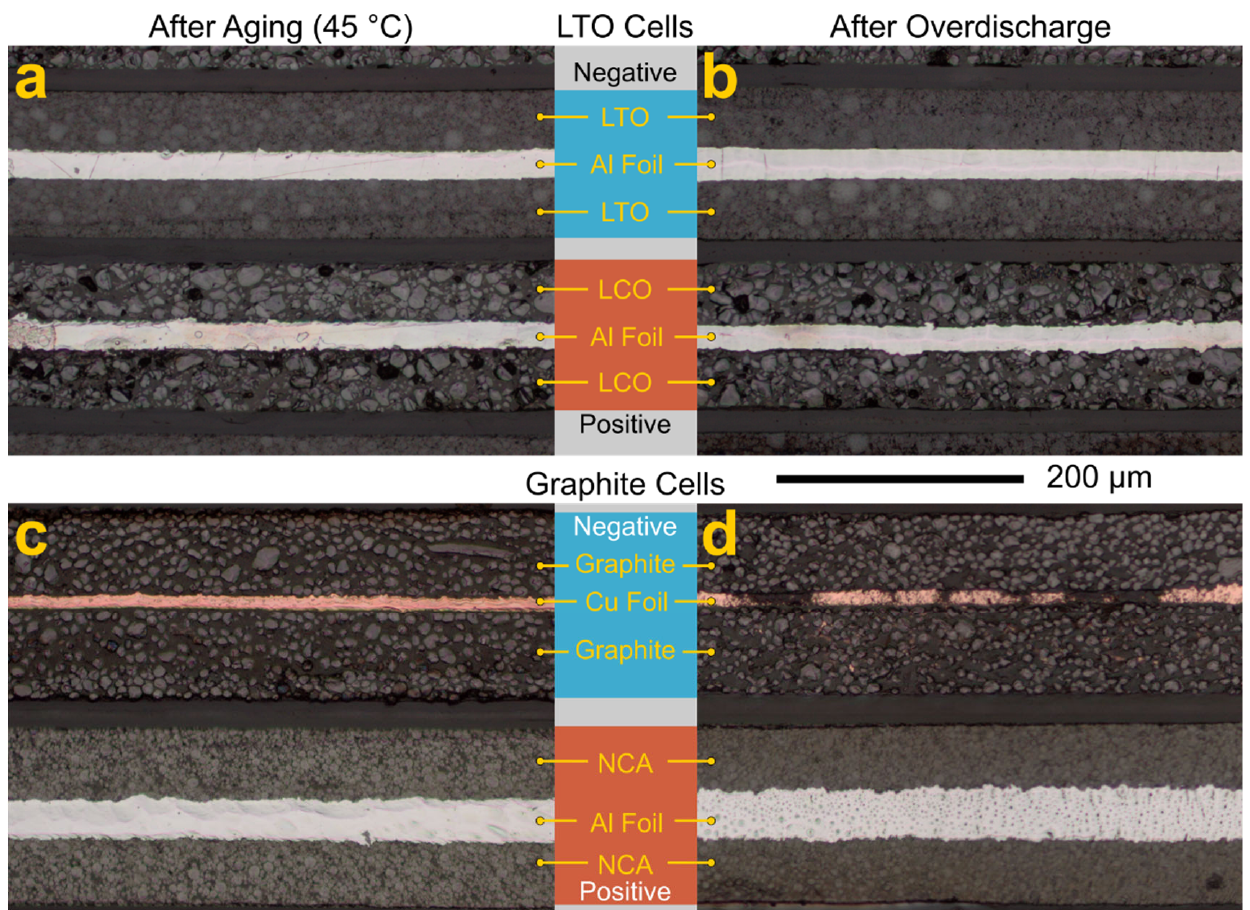
Figure 7. Optical microscopy of cross ‐ sectioned LTO ( top row ) and graphite ( bottom row ) cells. ( a ) An LTO cell, after aging at 45 °C; ( b ) an LTO cell after overdischarge testing; ( c ) a graphite cell after aging at 45 °C; ( d ) a graphite cell after overdischarge testing. Images are oriented so that the negative electrode is above the positive electrode. All images are scaled equally.